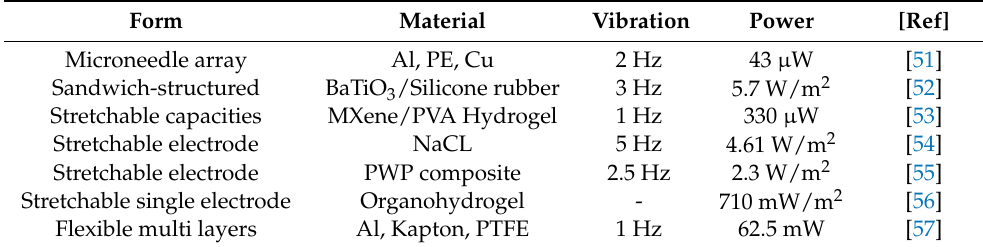
Table 6. Comparison triboelectric harvesters.